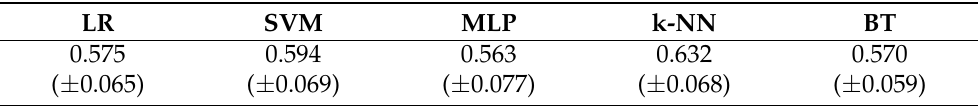
Table 14. AUC for different classifiers with the postmenopausal data partition (without performing feature